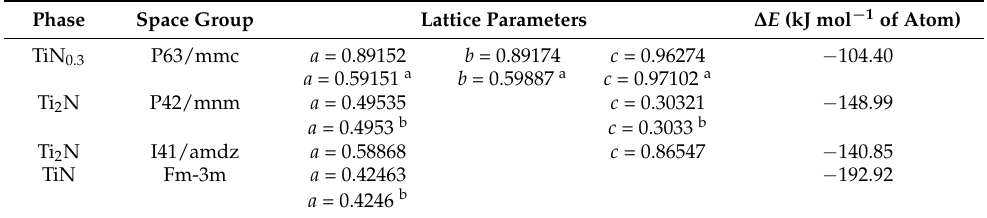
Figure 10. Dependence of the Gibbs free energy ( ∆ G ) on the temperature ( T ) for the Ti-N compounds. Table 6. The calculated lattice parameters ( a , b , and c in nm) of the Ti-N compounds by the first principle, compared with other theoretical results.